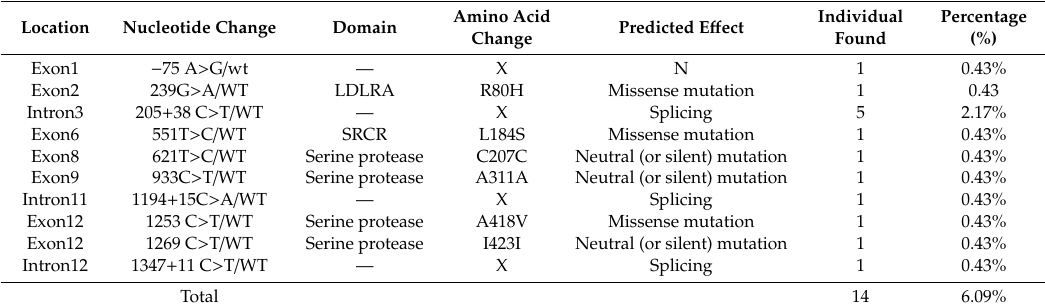
Table 2. Proportion of mutations of TMPRSS3 gene in 230 patients with nonsyndromic hearing loss (NSHL).